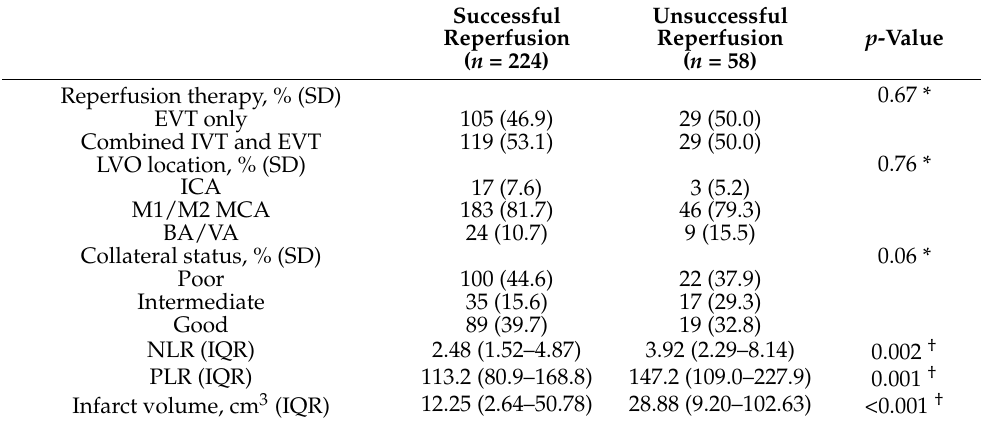
Figure 1. Distribution of final infarct volume according to tertile of NLR and PLR. Abbreviations: NLR, neutrophil-to-lymphocyte ratio; PLR, platelet-to-lymphocyte ratio; T1, lowest tertile; T2, middle tertile; T3, highest tertile. Range of tertiles: NLR T1 (0.30–1.88), NLR T2 (1.90–4.15), NLR T3 Table 2. Intervention-related findings and outcomes according to reperfusion status.